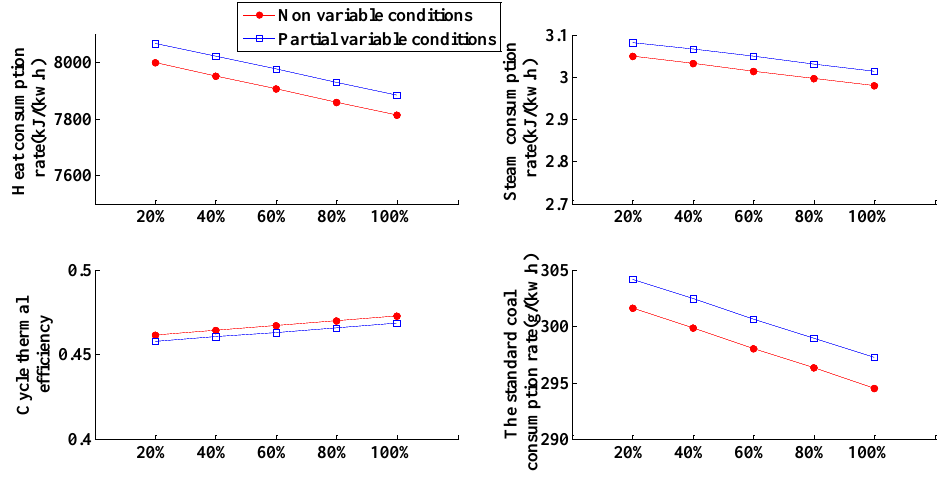
18 of 25 Figure 11. SAPG system 2nd thermal economy.